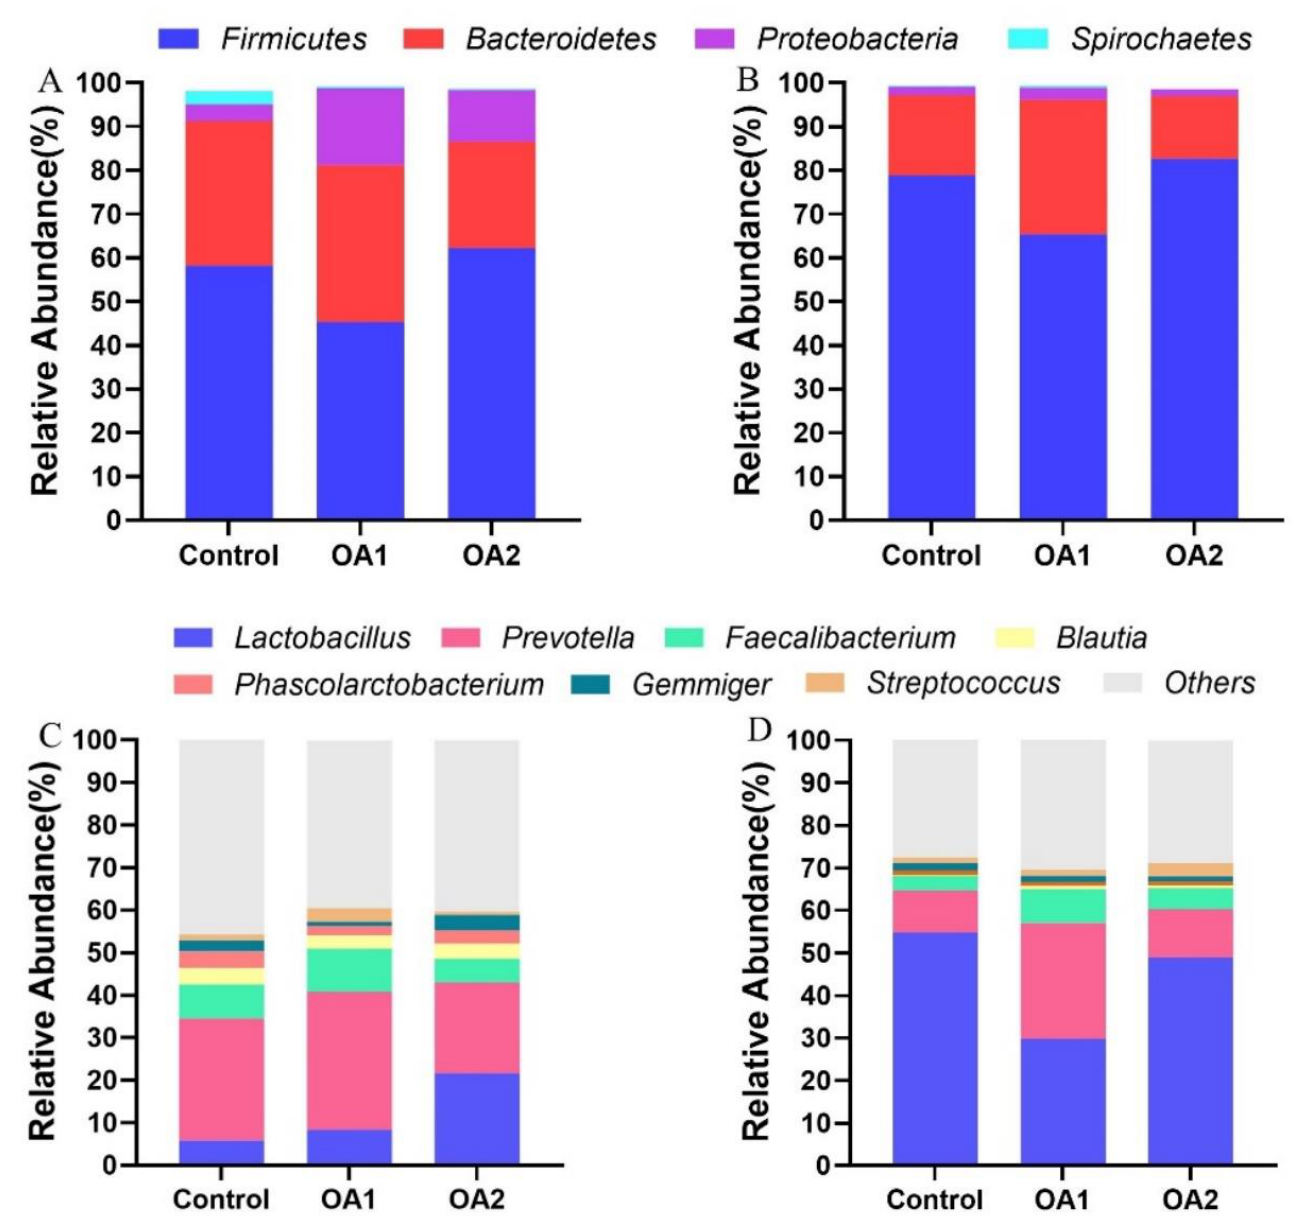
Figure 4. The analysis of composition of bacteria in cecum chyme. The phylum level of composition of bacteria at day 14 ( A ) and day 49 ( B ). The genus level of composition of bacteria at day 14 ( C ) and day 49 ( D ). The color-coded bar plot shows the relative abundance of bacterial phyla across the different